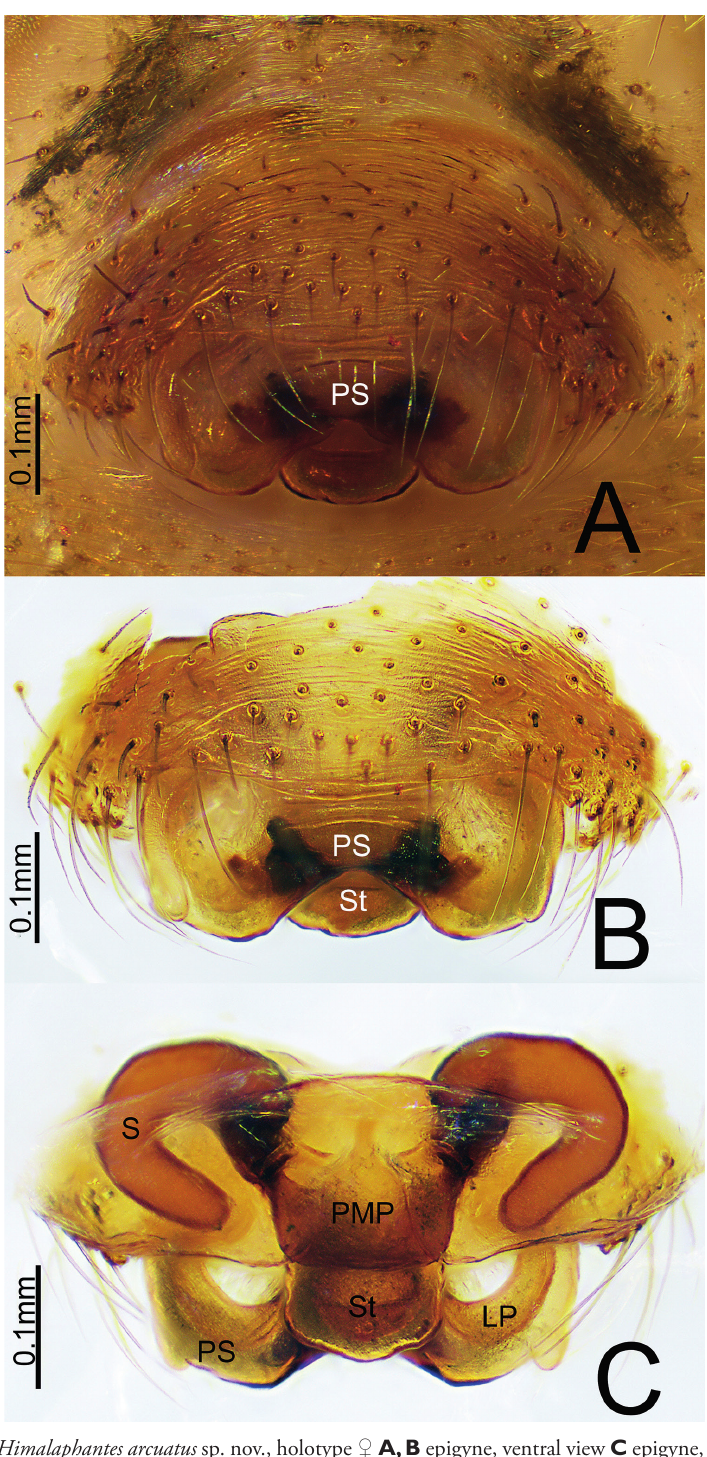
Figure 1. Himalaphantes arcuatus sp. nov., holotype ♀ A, B epigyne, ventral view C epigyne, dorsal